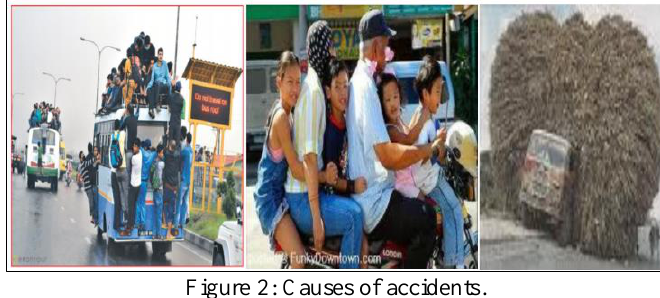
Figure 2: Causes of accidents.